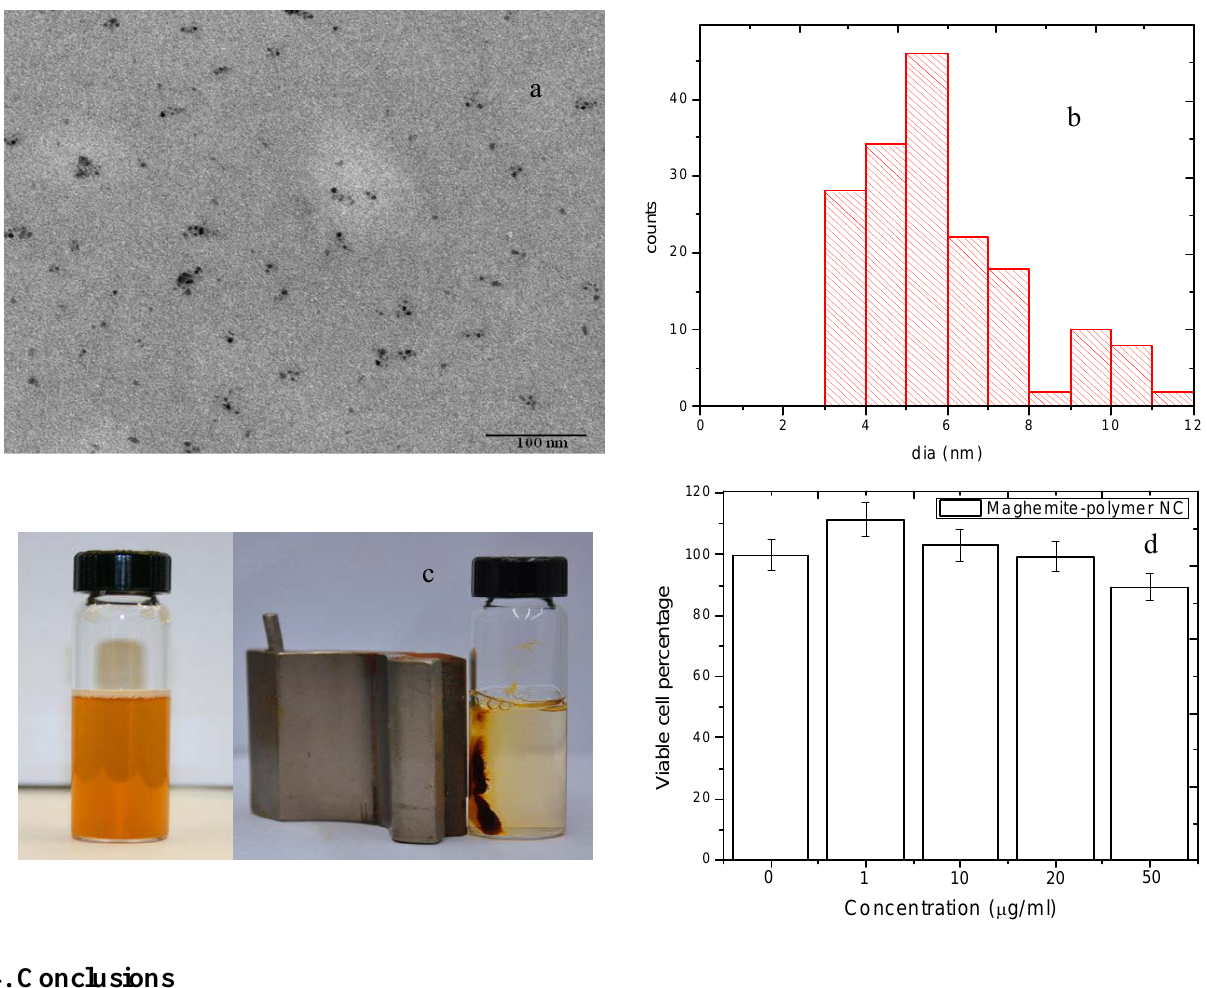
Figure 5. ( a ) TEM image of Pluronic 127-coated polymer-maghemite nanocomposites; ( b ) TEM nanoparticle size distribution histogram; ( c ) photograph of